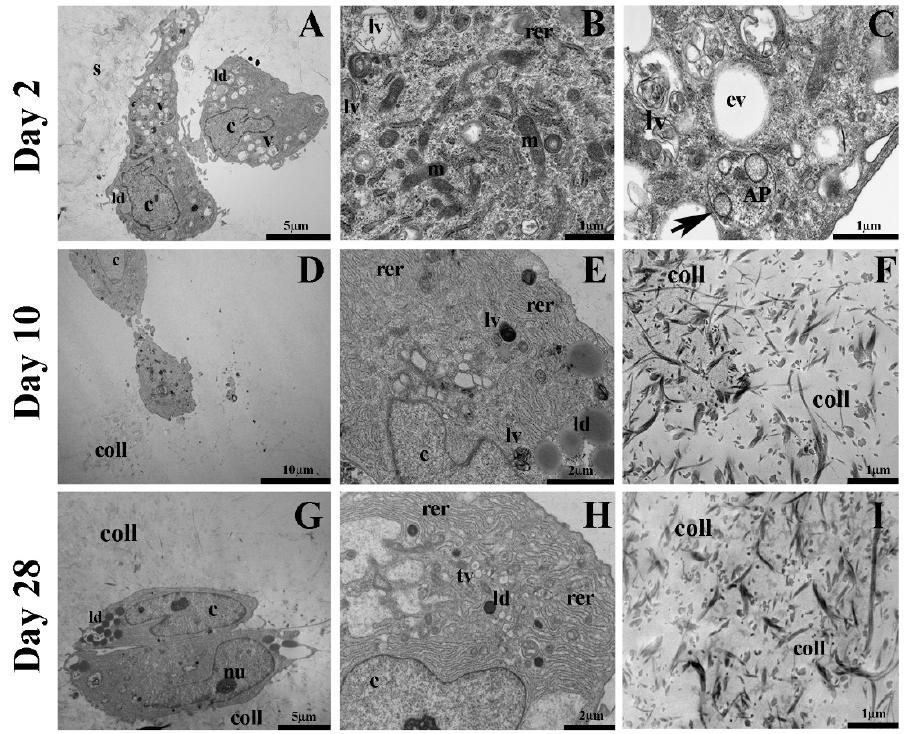
Figure 9. Representative transmission electron microscopy images of chondrogenic differentiated hASCs embedded in VG-RGD at days 2 ( A – C ), 10 ( D – F ), and 28 ( G – I ). In the images, s indicates VG-RGD hydrogel, c indicates dispersed chromatin, rer indicates rough endoplasmic reticulum, ld indicates lipid droplet, m indicates mitochondria, v indicates vacuoles, ev indicates empty vacuole, lv indicates degradative vacuole, black arrow indicates double membrane, AP indicates autophagosome, coll indicates collagen, and tv indicates transport vesicles. ( A , G ) bar 5 µm; ( E , H ) bar 2 µm; ( D ) bar 10 µm; ( B , C , F , I ) bar 1 µm.